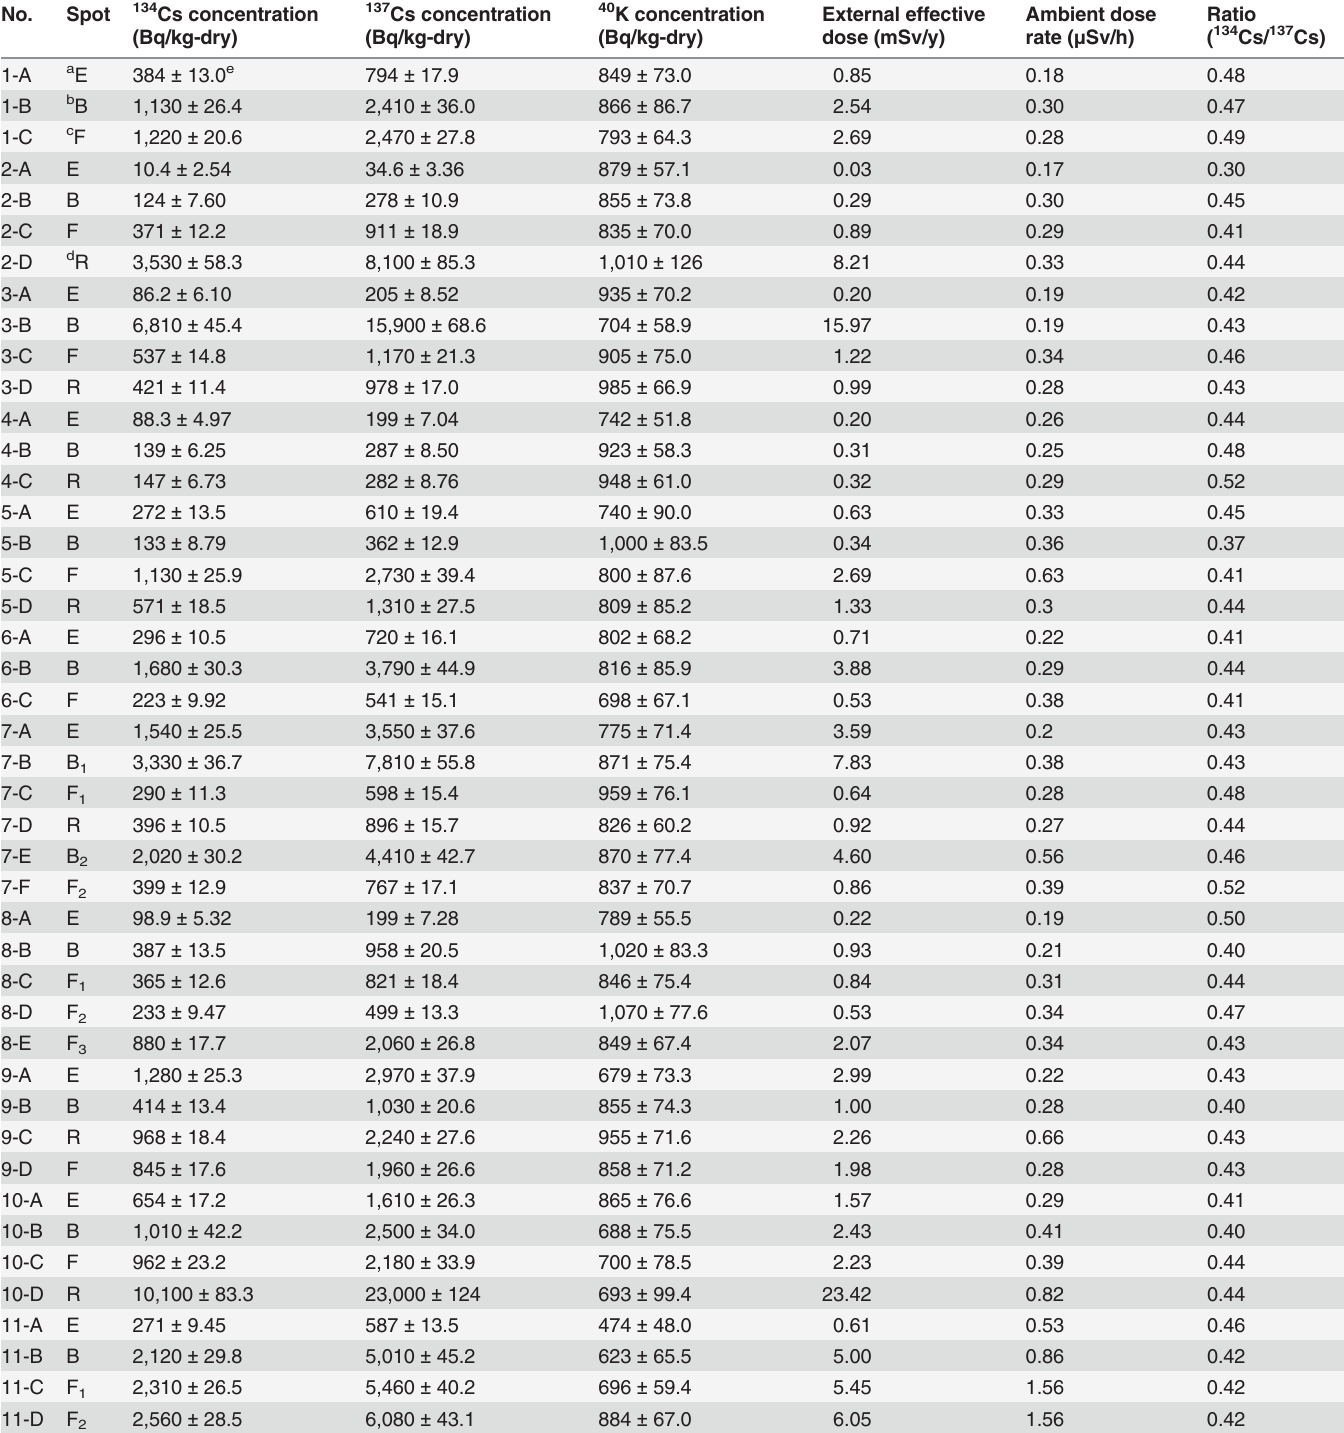
Table 2. Distribution of detected artificial radionuclides in soil